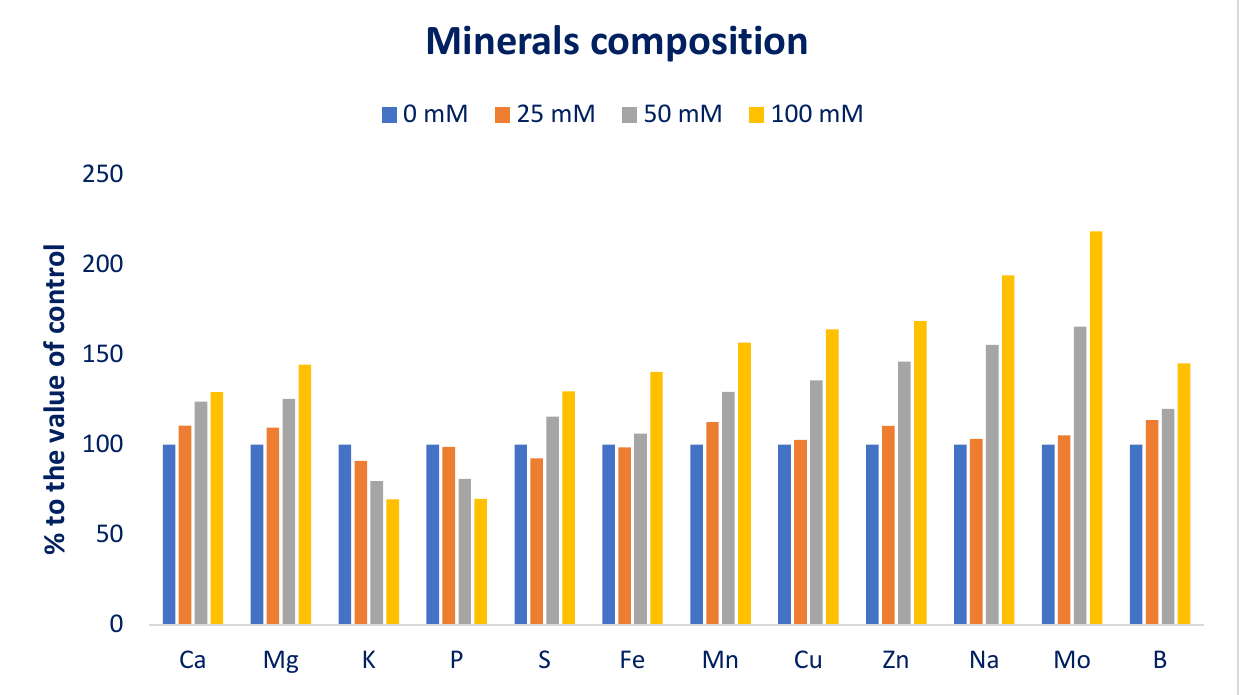
Figure 6. Comparison of the salt-induced increment in mineral composition (%) over control in Lal-shak.